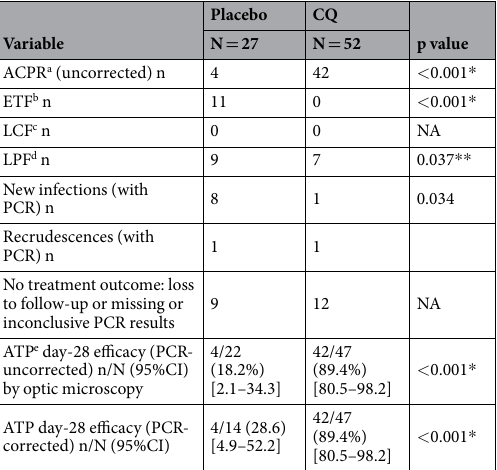
Table 2. Treatment outcomes on day 28, according to treatment received (Placebo or chloroquine). a ACPR:adequate clinical and parasitological response; b ETF: early treatment failure; c LCF: late clinical failure; d LPF: late parasitological failure; e ATP: According to protocol; NA: not applicable. * Fisher’s exact test; ** Chi- squared test.